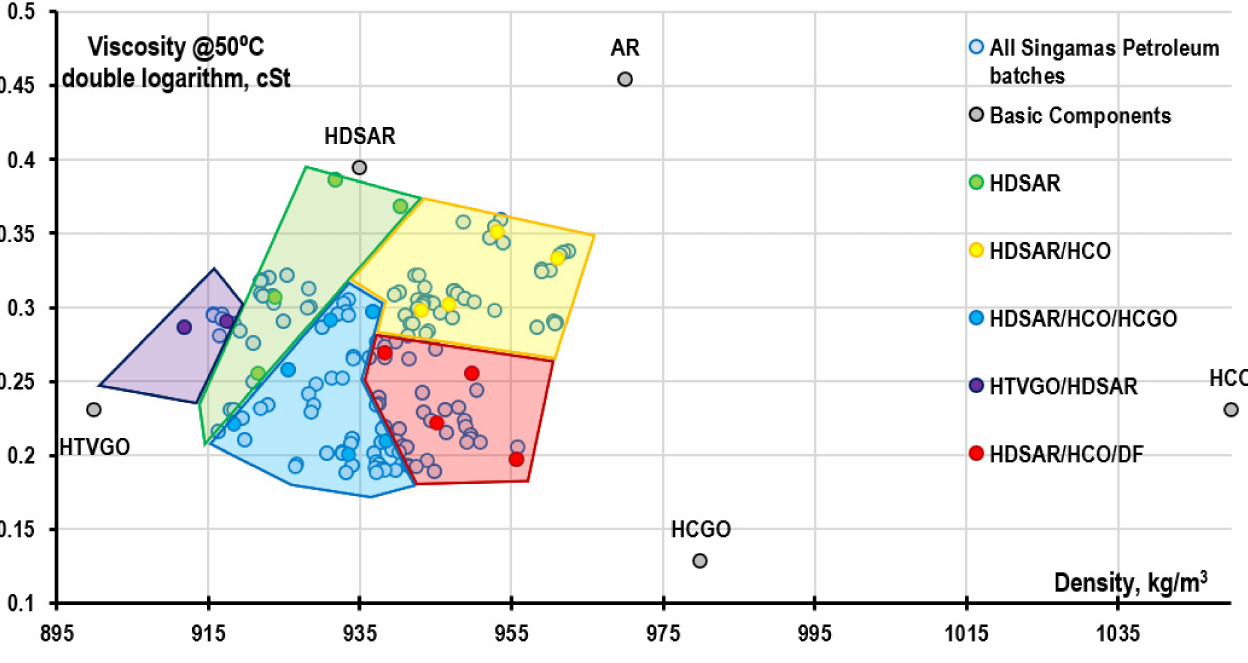
Figure 12. The most common types of fuel compositions and all Singamas Petroleum batches in logarithmic coordinates